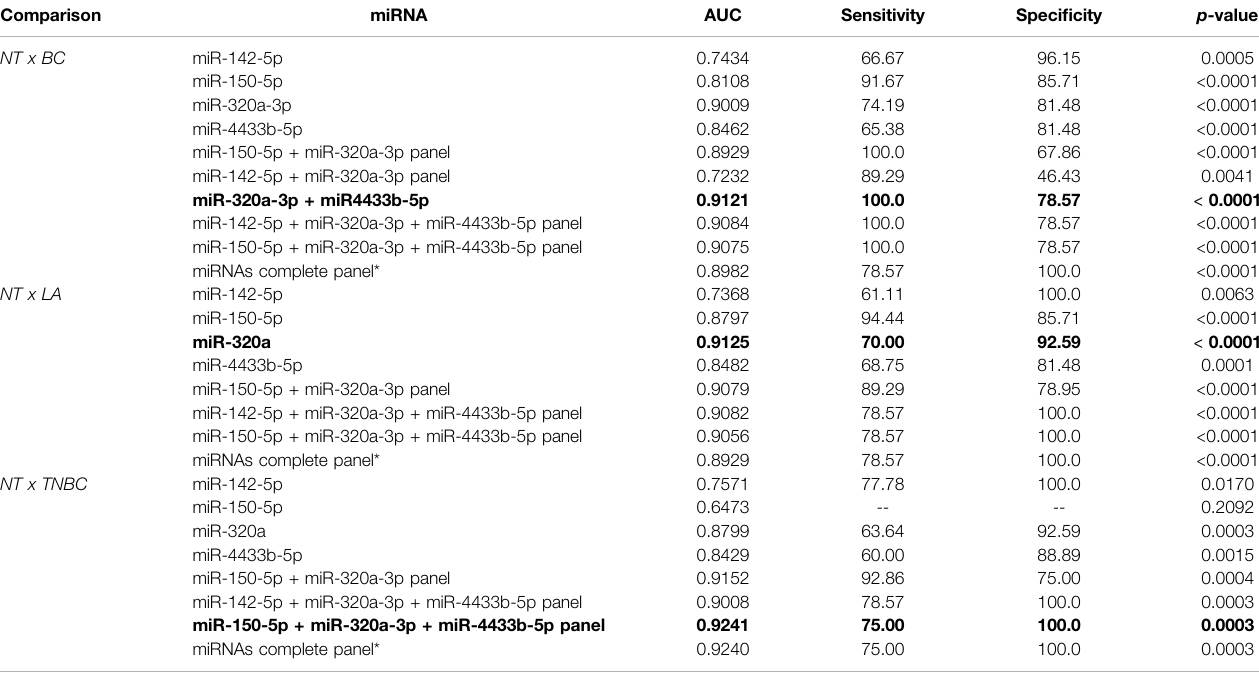
TABLE 2 | Data about receiver operating characteristic (ROC) curves to investigate the diagnostic potential of miRNAs on Brazilian tissue samples. Comparison